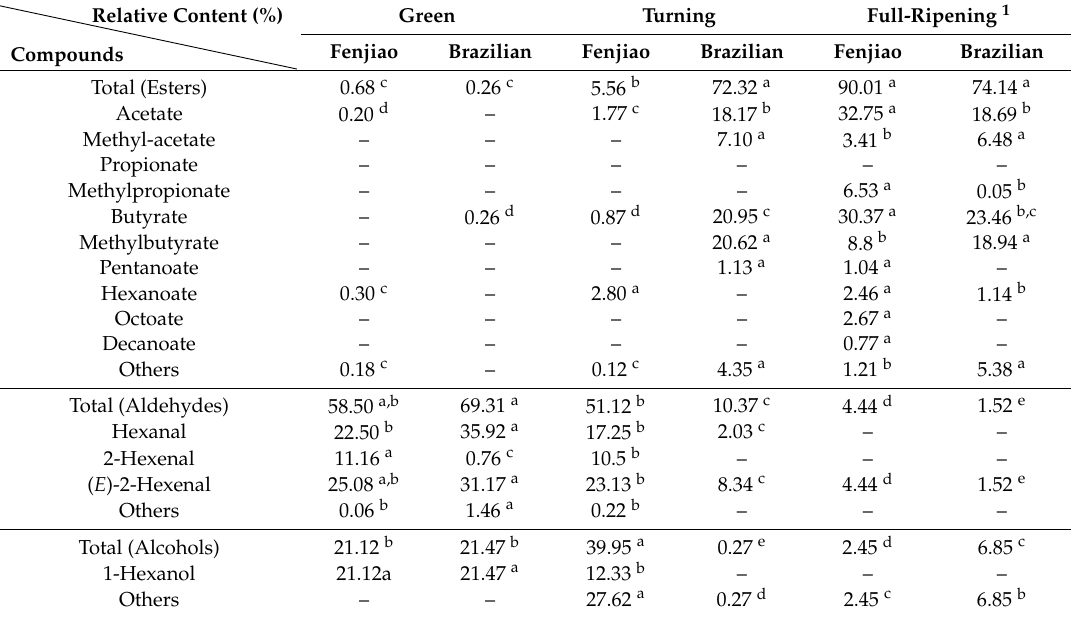
Table 4. Comparison of the main volatiles compounds in Brazilian and Fenjiao banana fruit at various stages of